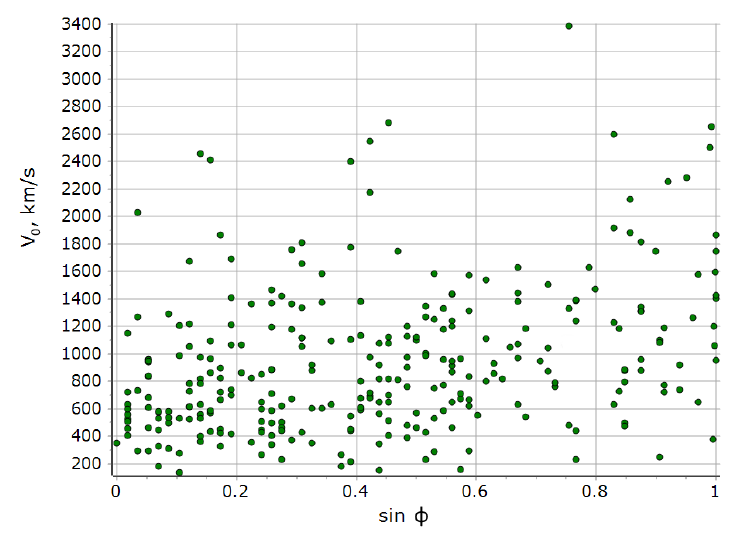
Figure 1. Distribution of the initial CME linear speeds depending on sin φ for 288